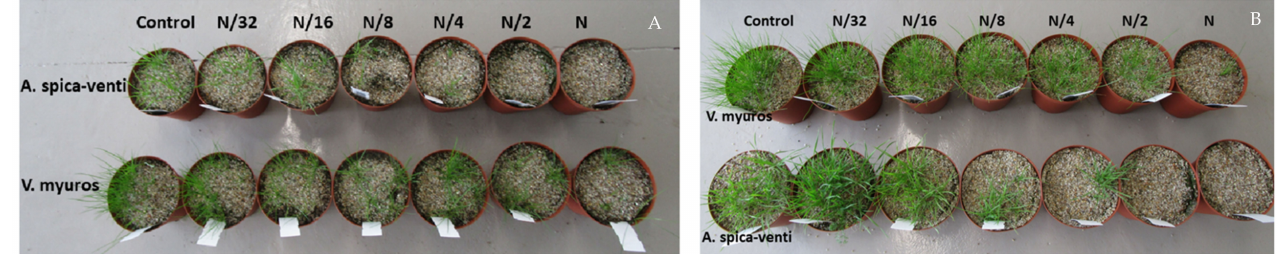
Figure 5. Photographic illustration of prosulfocarb dose–response for the Vulpia myuros and Apera spica-venti sprayed on: pre-emergent seeds ( A ); and germinating seedlings ( B ). The normal dose (N) of prosulfocarb was 800 g/ha.